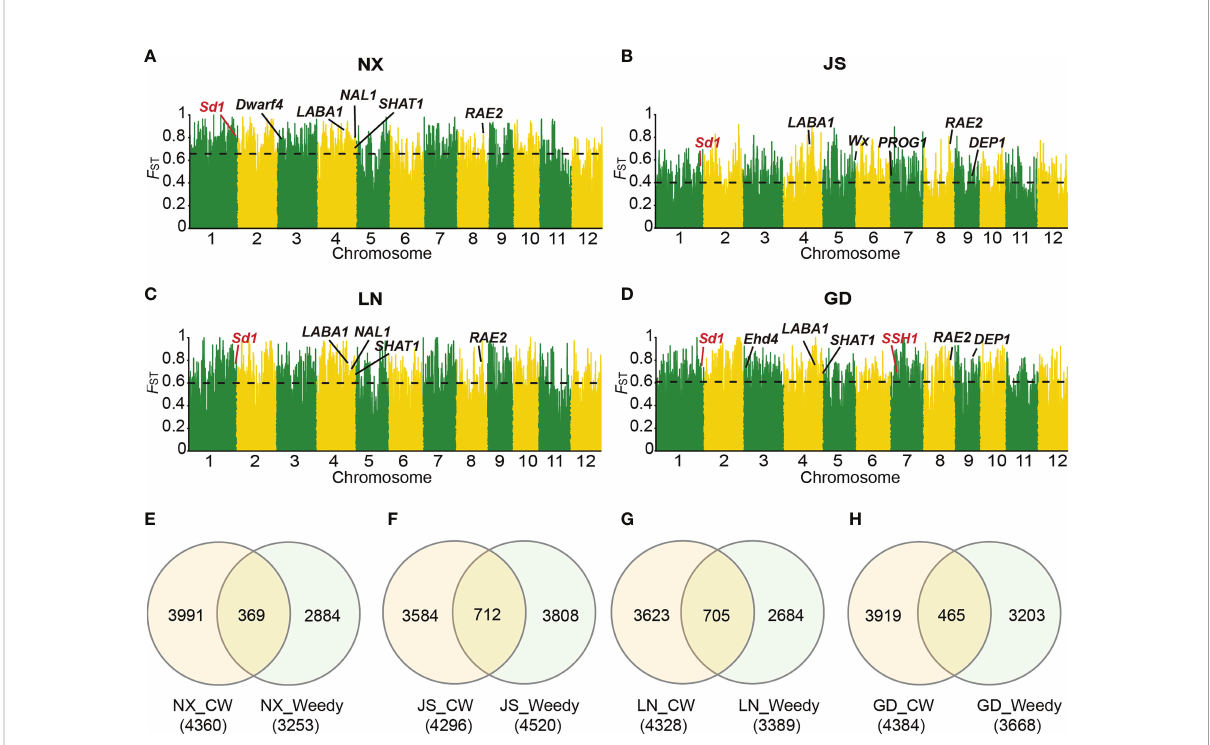
FIGURE 4 Genomic differentiation between Asian wild rice and cultivated rice from different locations. (A-D) SV- F ST between Asian wild rice and cultivated rice from NX (A) , JS (B) , LN (C) and GD (D) , respectively. Genes emphasized in the text were marked in red. Horizontal dashed lines correspond to the top 5% threshold. (E-H) The intersection of divergent gene regions identi fi ed through SV- F ST between Asian wild rice and cultivated rice and that between weedy and cultivated rice in four regions NX (E) , JS (F) , LN (G) and GD (H) , respectively. CW means cultivated